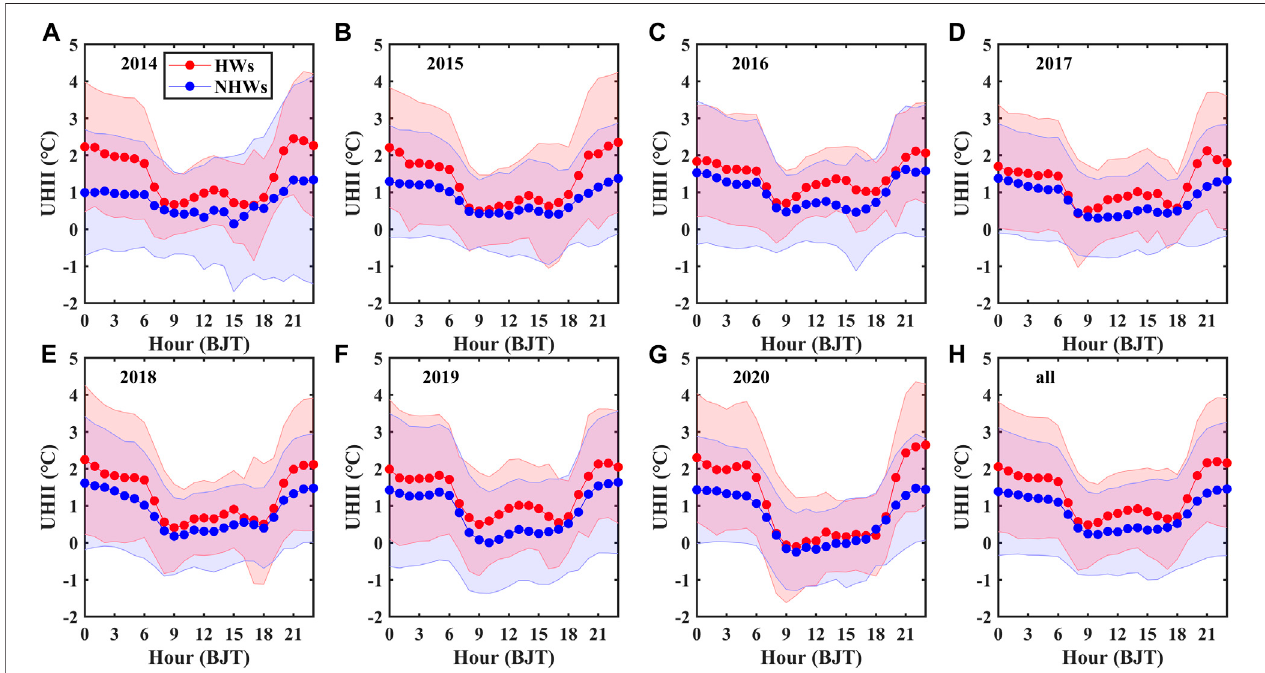
FIGURE 2 | Diurnal variation ofUHIIbetween HW and NHW periods during summertime (June – August) 2014 – 2020. HW and NHW periods are indicated by red and blue, respectively. Lines denote average UHII values and shaded areas present the standard deviation of the average UHII values according to all urban reference stations.